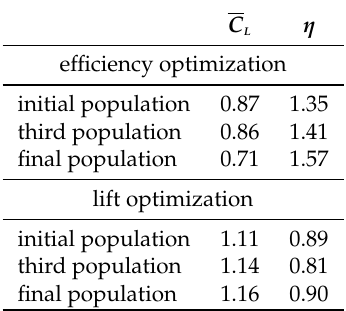
Table 4. Phase-averaged lift and efficiency measured for the pitching motions of the best individuals of the first, third and final population for the genetic algorithm efficiency and lift